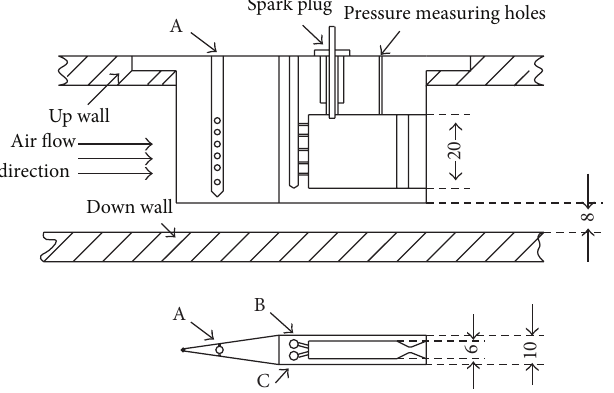
Figure 1: Structure of the strut-jet unit: mm.